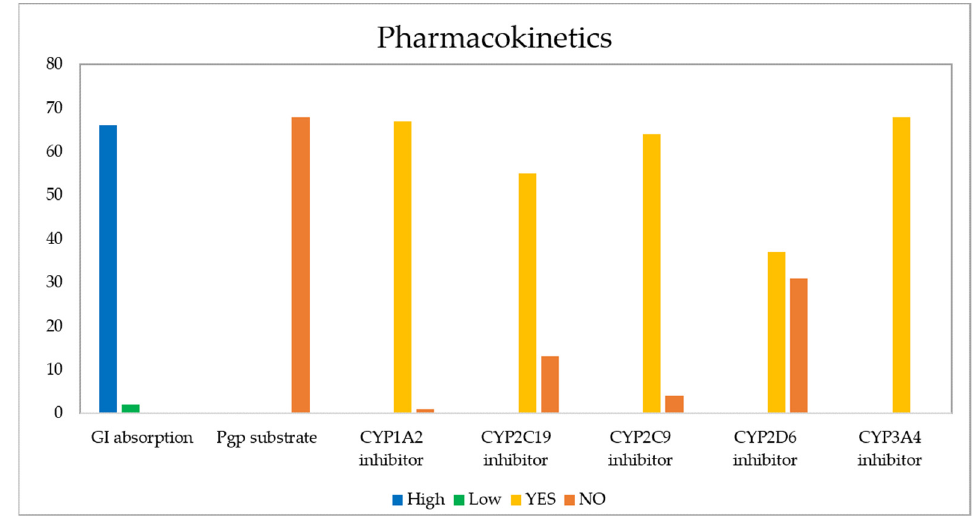
Figure 12. Pharmacokinetic properties calculated for the 68 naphthoquinone derivatives.